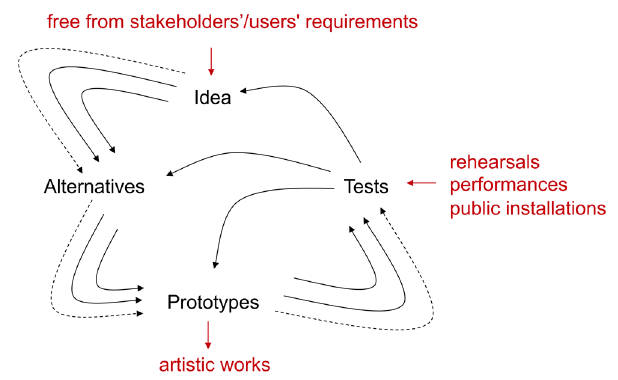
Figure 1. A design-oriented AR methodological framework. The multiple arrows indicate how an initial idea is developed in different (alternative) ways and generates different